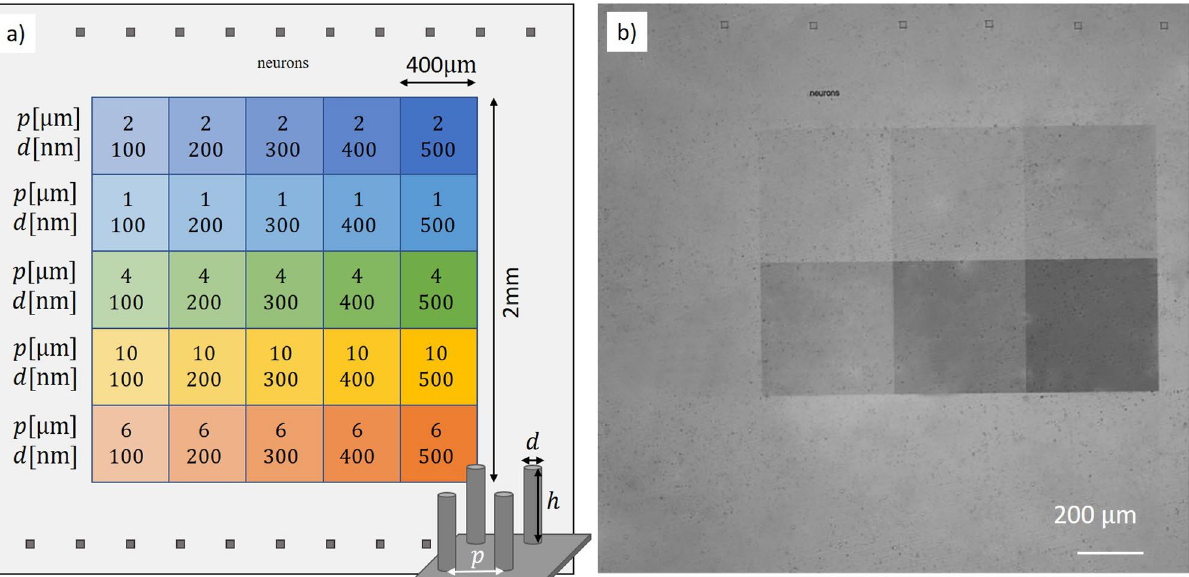
Figure 1. ( a ) Design of 25 nanopillar arrays with different geometrical parameters on the same chip, each array covering an area of 400 µ m × 400 µ m . They all present the same height h ∼ 1 µ m. ( b ) Optical image of the diamond surface before plating the neurons. The different pillar densities and diameters yield different colors. Pillars with diameters d ≤ 300 nm and/or pitch p ≥ 2 µ m cannot be clearly